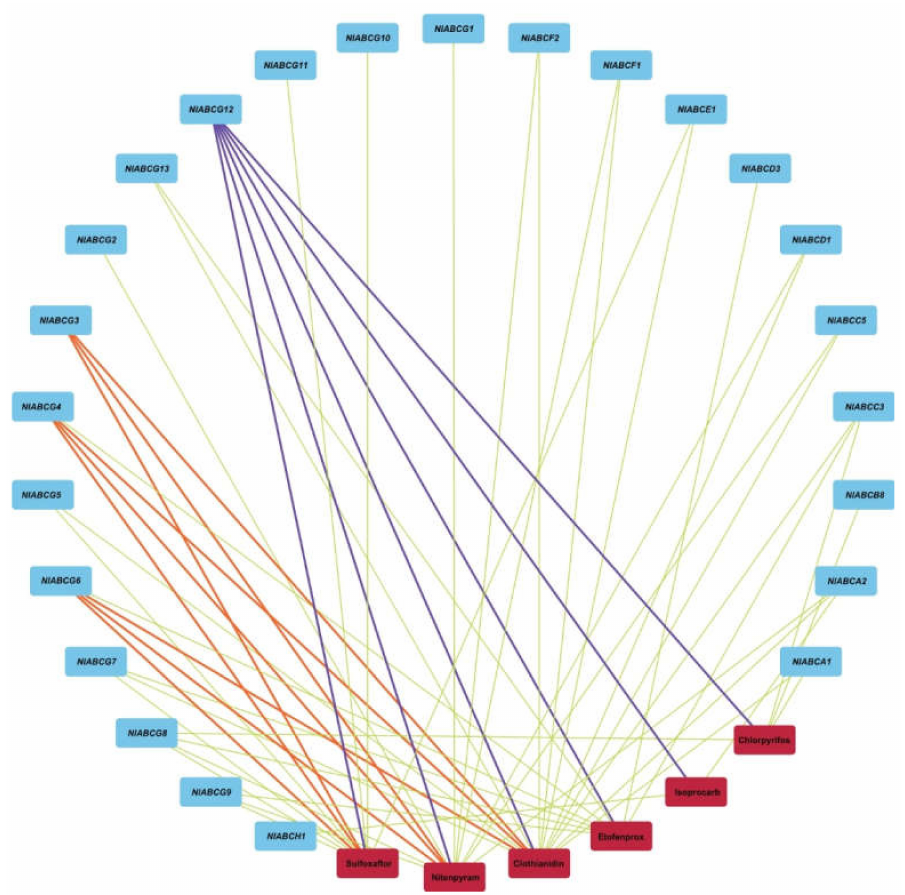
Figure 5. Summary of genes that were significantly upregulated after exposure to di ff erent insecticides. The link indicates that the gene was significantly upregulated after insecticide induction. The orange line indicates the genes that are upregulated after induction by three neonicotinoid insecticides. The purple line indicates genes that are upregulated after induction of six insecticides ( p <